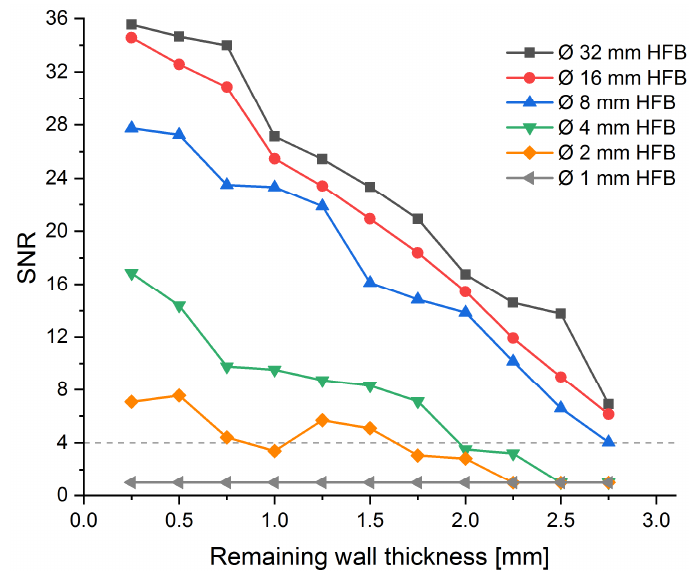
Figure 6. Determined SNR values of blind holes with flat bottoms of different diameters for different remaining wall thicknesses.